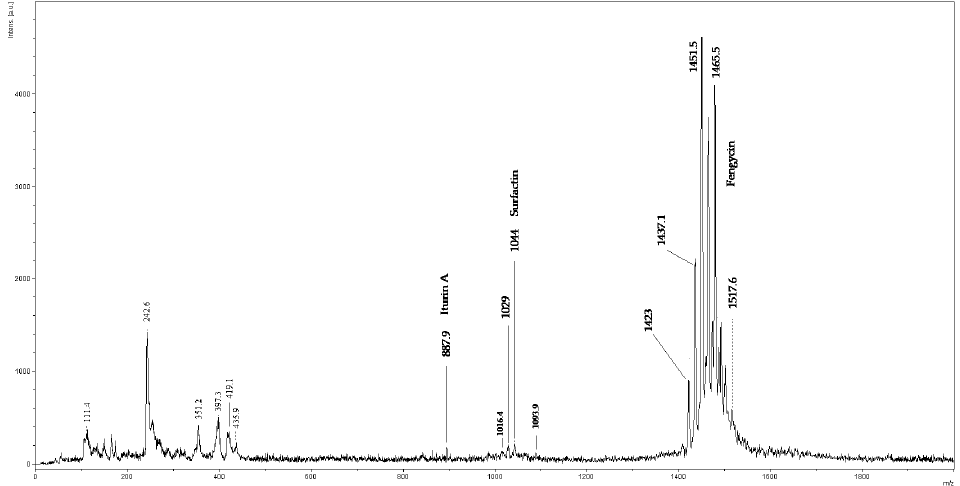
6 of 20 Figure 1. Chromatogram of standards ( up ) and LPs from B. amyloliquefaciens 3/22 ( down ), contain- ing components of iturin A, surfactin and fengycin. 2.4. MALDI-TOF/MS Analysis The lyophilized extract of LPs from B. amyloliquefaciens 3/22 was subjected to MALDI- TOF/MS analysis as an acetonitrile solution. In the spectra of isolated LP, peaks with masses very similar to LP compounds were detected. As shown in Figure 2, the most in- tensive signals in the m / z range of 1400–1600 were observed in the MALDI-TOF/MS spec-